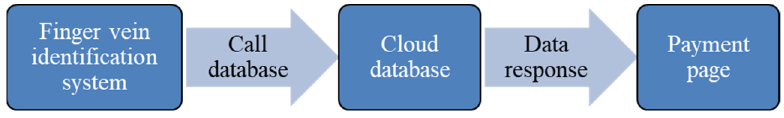
Figure 7. Relation graph of the electronic payment system.